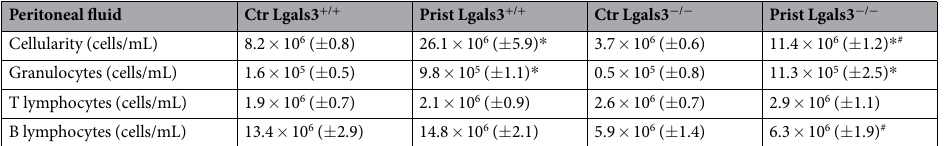
Table 2. Number of cells in the peritoneal fluid 18 h after pristane injection. Ctr: control mice; Prist: pristane- injected mice. ( * ) indicates p < 0.05 to pristane-treated mice compared with respective controls. ( # ) indicates p < 0.05 to pristane-induced Lgals-3 − / − mice compared with pristane-induced Lgals-3 + / +